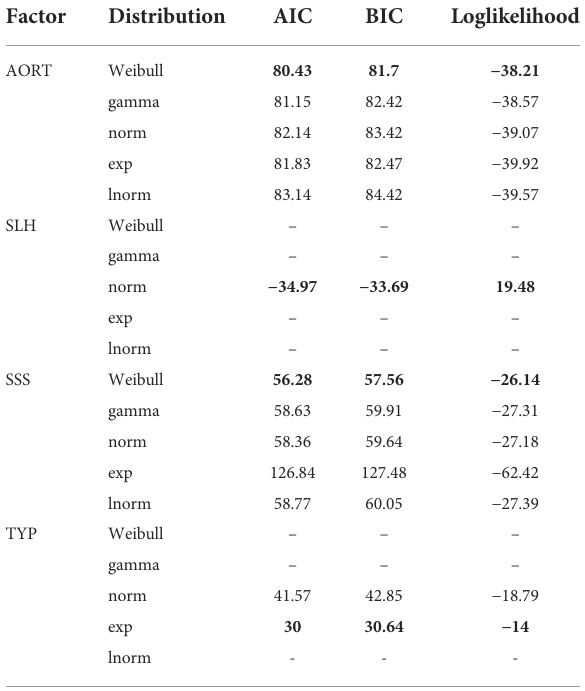
TABLE 1 Comparison of fi tting results of different distributions of environmental factors.